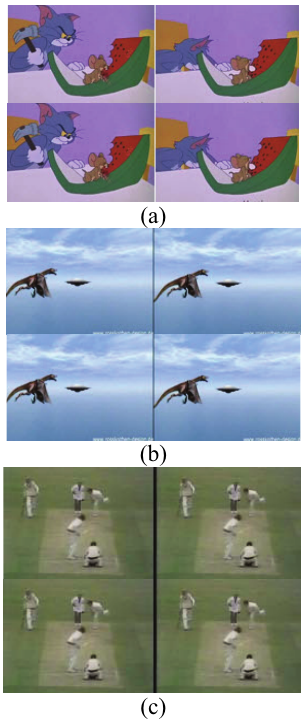
Fig.5.1. (a) (b) & (c) Elementary frames of 3 different shots segmented from 3 different video